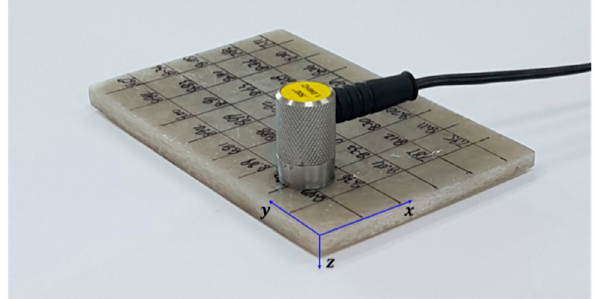
Figure 3. Example pulse echo ultrasonic device used in the experiment.